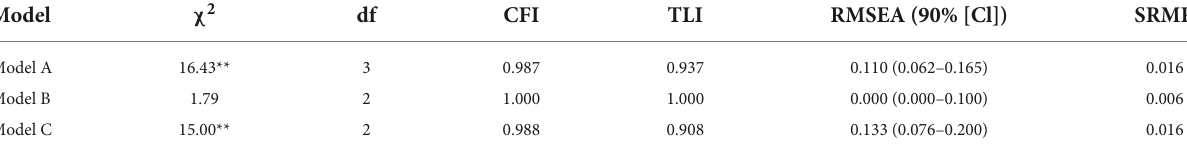
TABLE 3 Fit indices for the